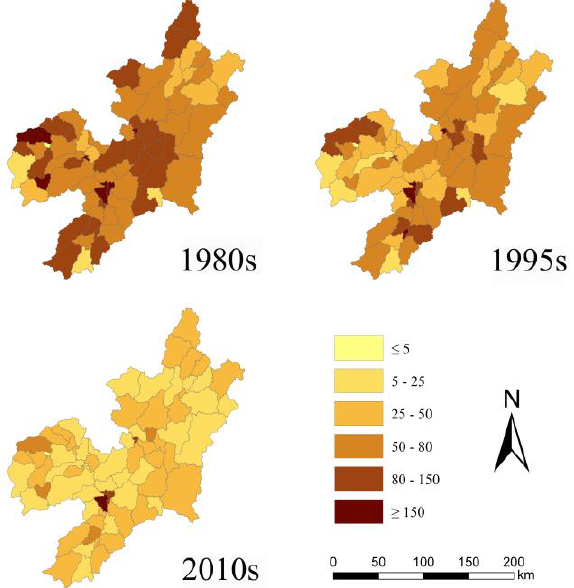
Figure 3. Soil erosion distribution of each sub-basin for the years 1980s, 1995s, and 2010s (t/ha/yr).